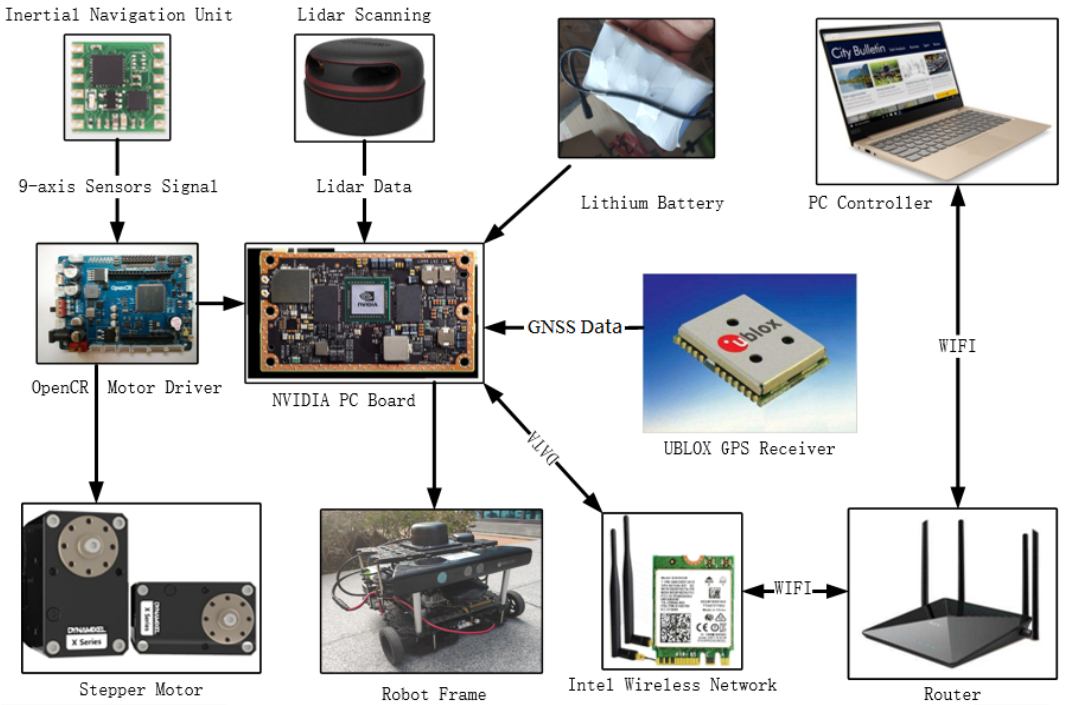
Figure 2. Hardware composition diagram of the simulation navigation